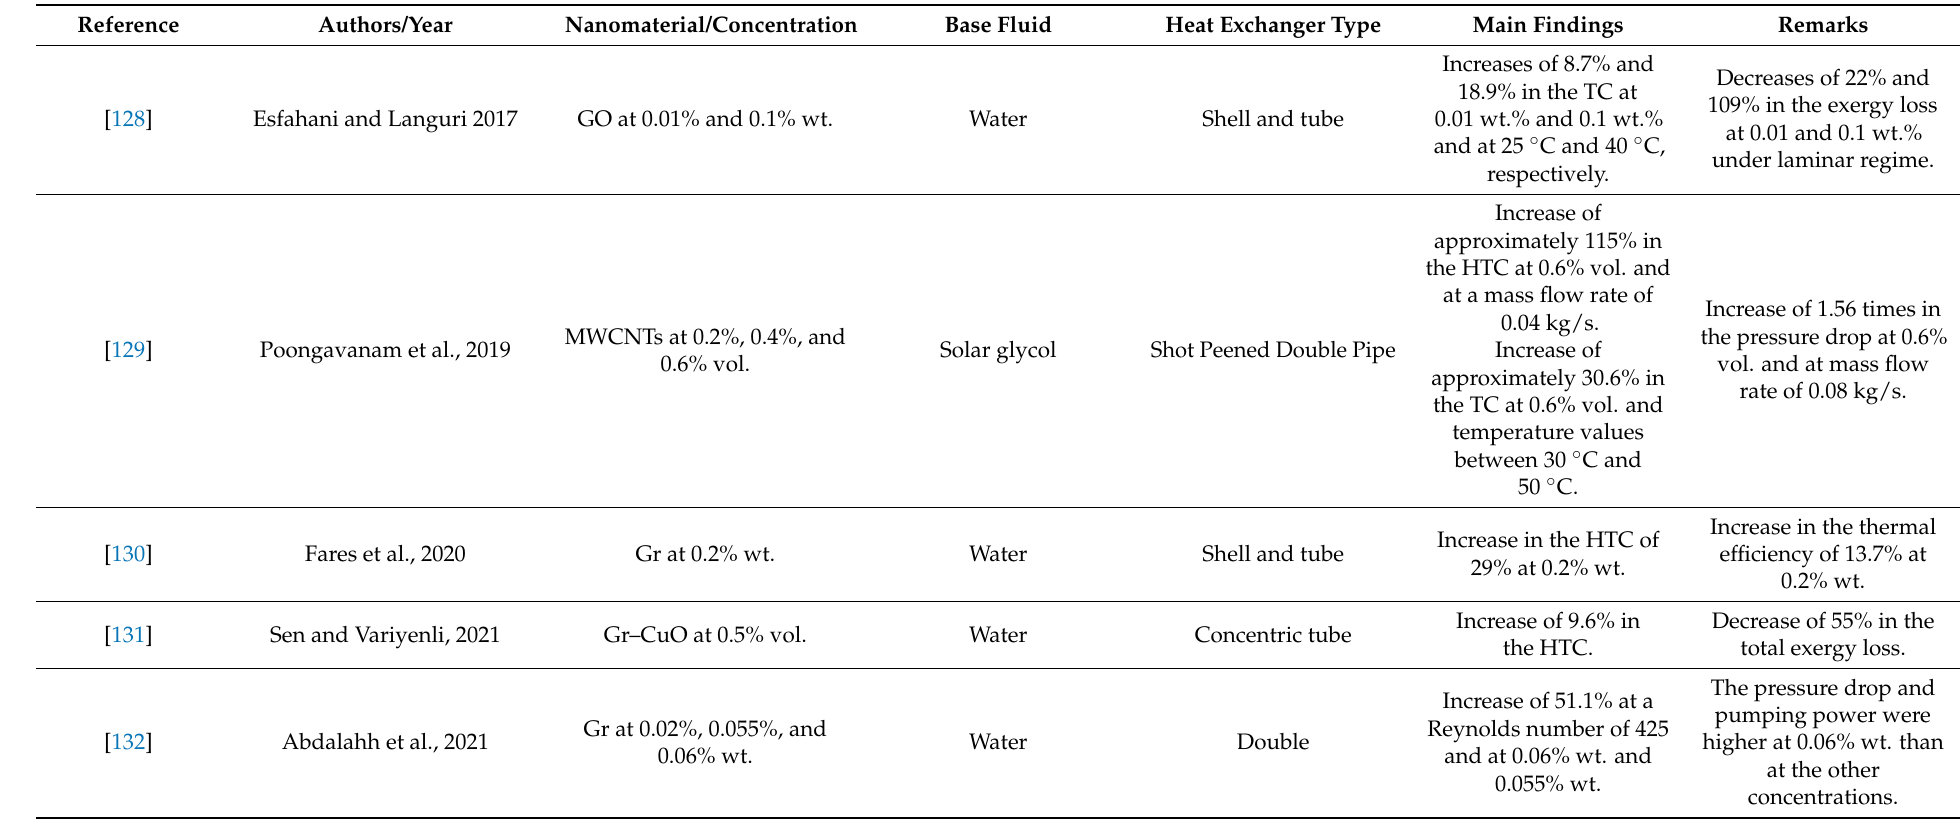
Table 7. Recent experimental works on the use of 2D nanofluids in heat